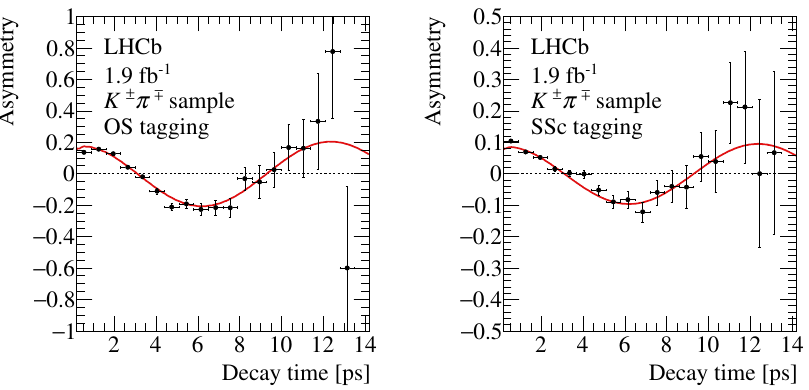
Figure 5 . Time-dependent asymmetries for K (cid:6) (cid:25) (cid:7) candidates with 5 : 20 < m ( K (cid:6) (cid:25) (cid:7) ) < 5 : 32 GeV/ c 2 : (left) using the OS-tagging decision and (right) the SSc-tagging decision. The re- sult of the simultaneous (cid:12)t is overlaid.